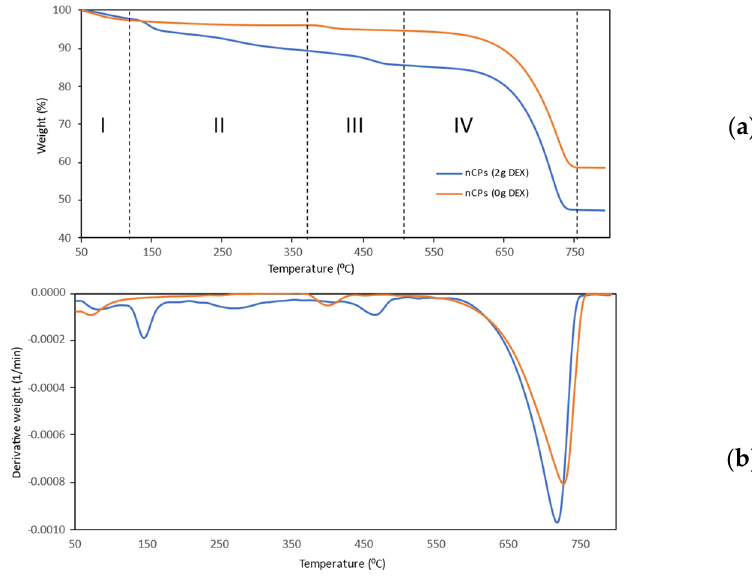
Figure 5. TGA ( a ) and DTG ( b ) curves of nCPs (0g DEX) and nCPs (2g DEX).